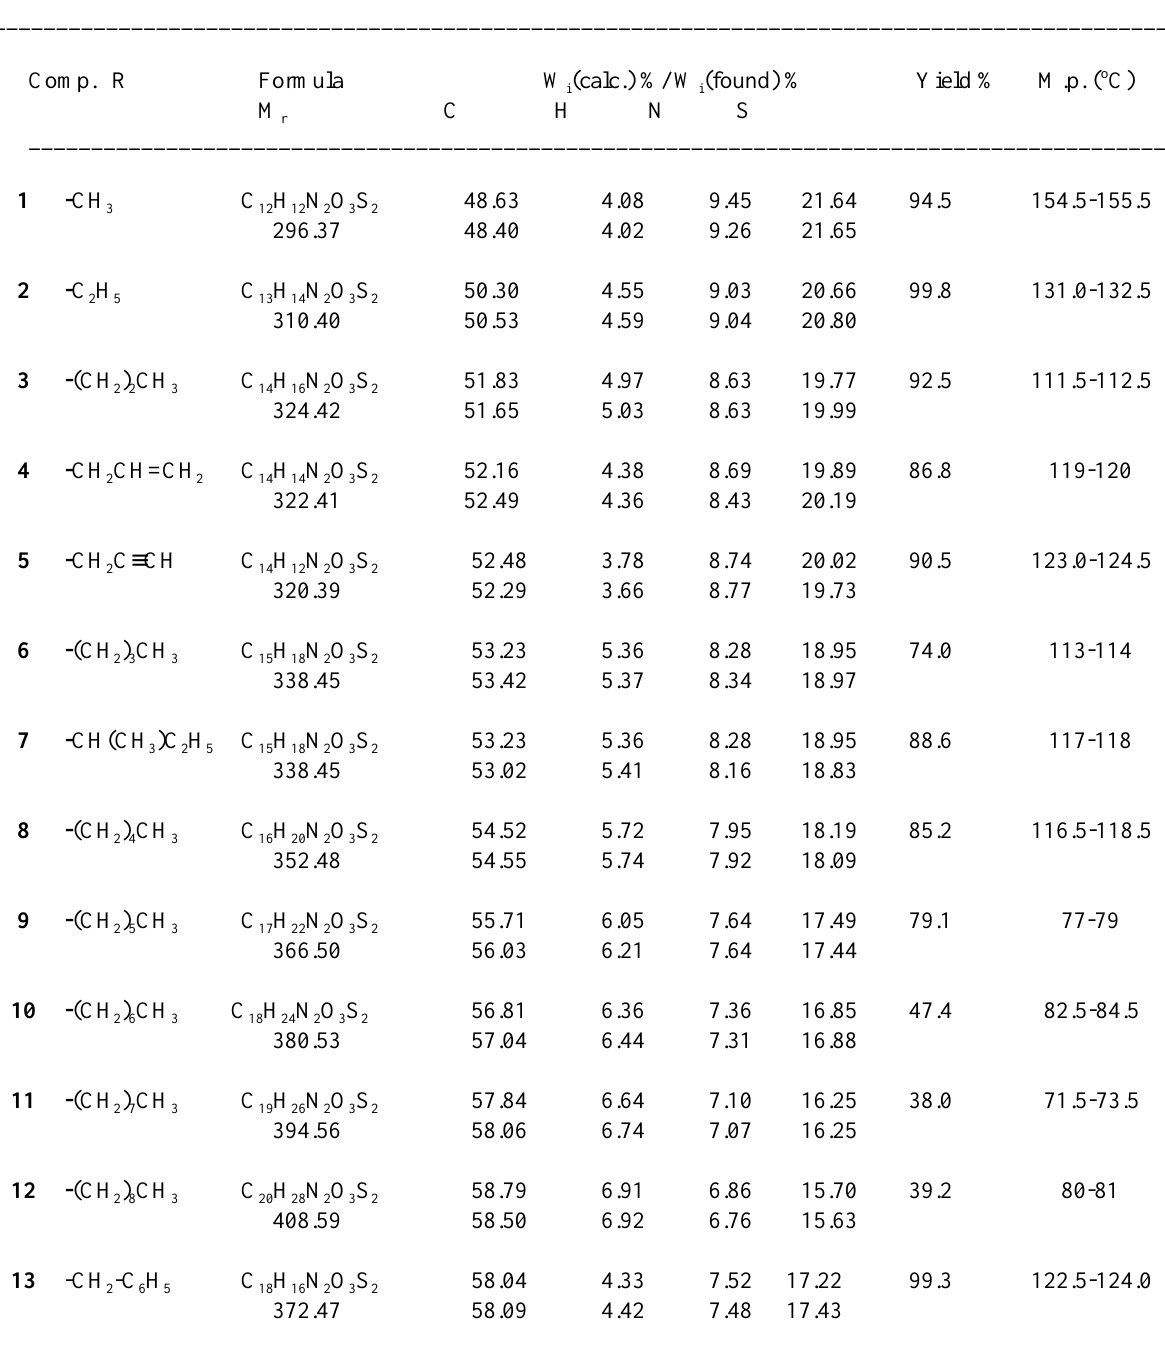
Table 1. Characterization of the prepared 2-(6-acetamidobenzothiazolethio)acetic acid esters. CH 3